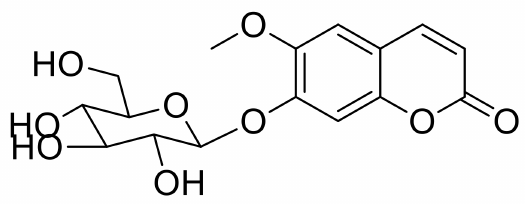
Figure 1. Chemical structure of